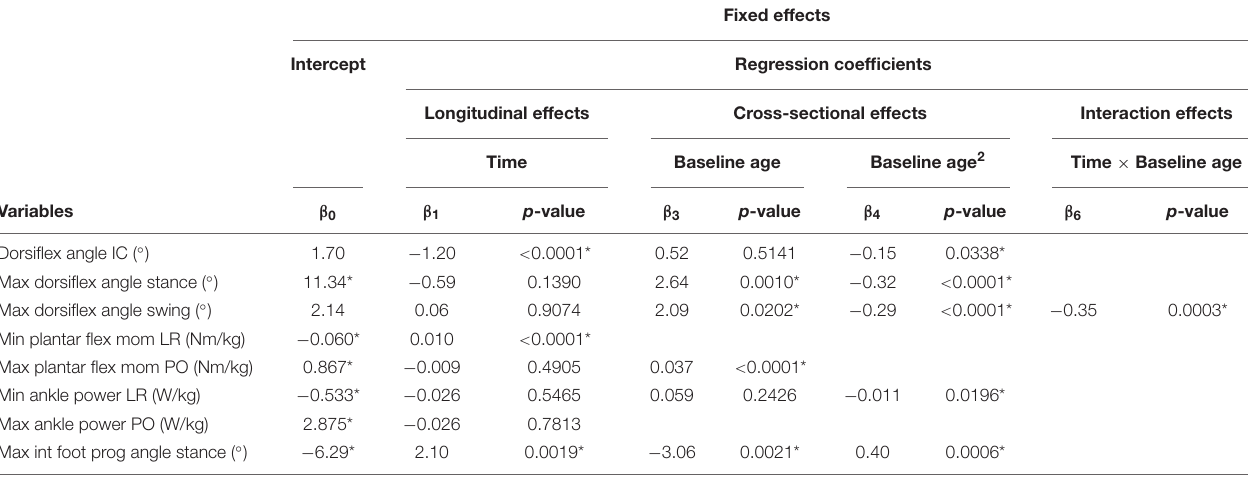
TABLE 7 | Results of linear mixed effect models with ankle kinematics and kinetics as responses in children with